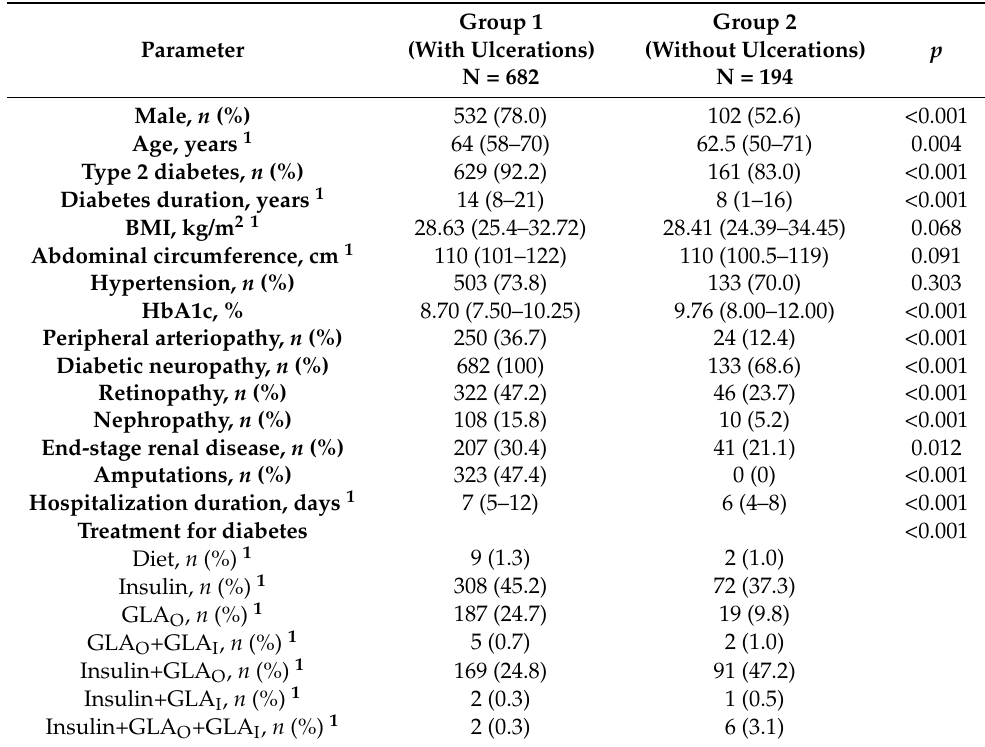
Table 2. Baseline characteristics of study participants, according to the presence or absence of foot